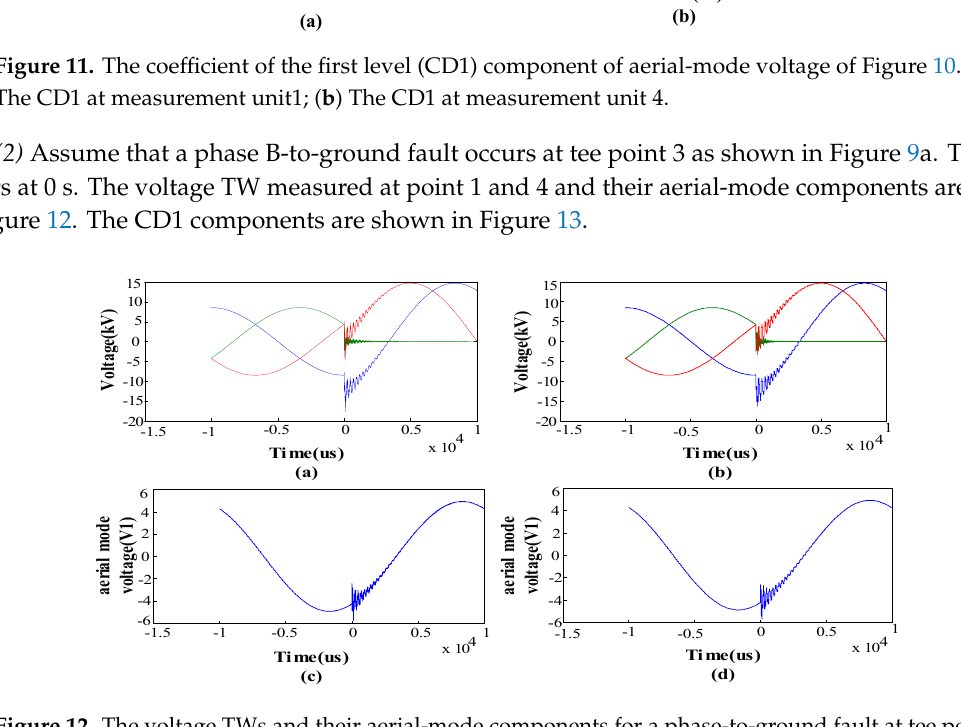
Figure 12. The voltage TWs and their aerial-mode components for a phase-to-ground fault at tee point 3. ( a ) The voltage TW measured at measurement unit 1; ( b ) The voltage TW measured at measurement unit 4; ( c ) The aerial-mode component of ( a ); ( d ) The aerial-mode component of ( b ).